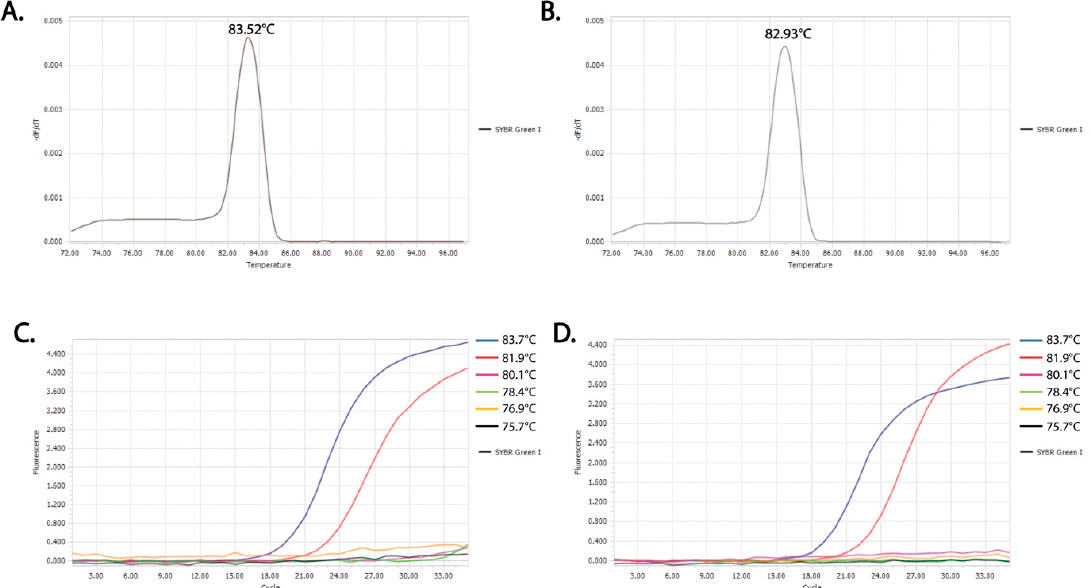
Figure 2. SYBR Green Real time PCR result for the determination of T c : Melting curve analysis of PCR products for the detection of T m for P1 fragment ( A ) and P2 fragment ( B ) and fluorescent amplification curves at different T x values (83.7 °C, 81.9 °C, 80.1 °C, 78.4 °C, 76.9 °C, and 75.7 °C) to identify T c values for COLD-PCR assays of P1 fragment ( C ) and P2 fragments ( D ).